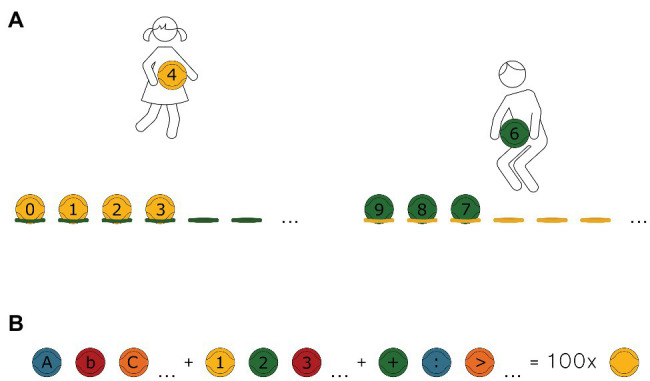
Eduball educational balls. (A) Example of an educational game: “From 0 to 9.” The students, divided into two teams (yellow and green), freely move across the whole gymnasium. At the teacher’s signal, the students with the yellow balls need to line up as fast as they can from smallest to biggest number. The green team has to line up from biggest to smallest number. (B) Eduball educational balls means 100 balls used for mini-games for teams in five colors (yellow, green, blue, red, and orange) with painted (in black) letters of alphabet (large and small letters), digits from 1 to 9 and 0, mathematical operation symbols [addition (+), subtraction (−), multiplication (×), division (/), greater than (>), smaller than (<), and brackets ()] and symbols of the electronic mail (@). Placing letters, numbers, and characters on the balls allowed for their comprehensive use in various areas of science during physical activities.